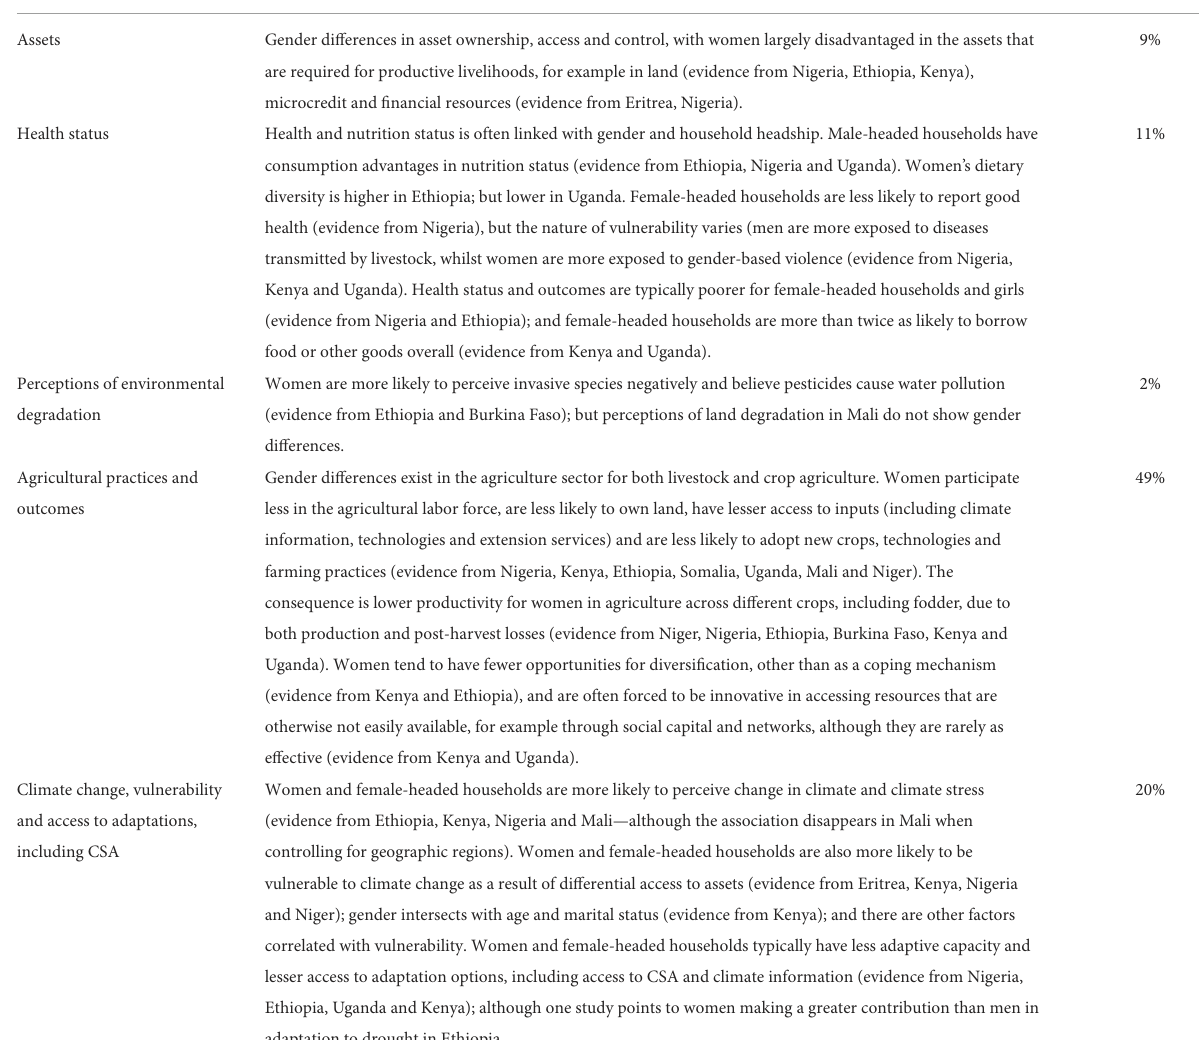
TABLE 2 Summary of gender differences across various